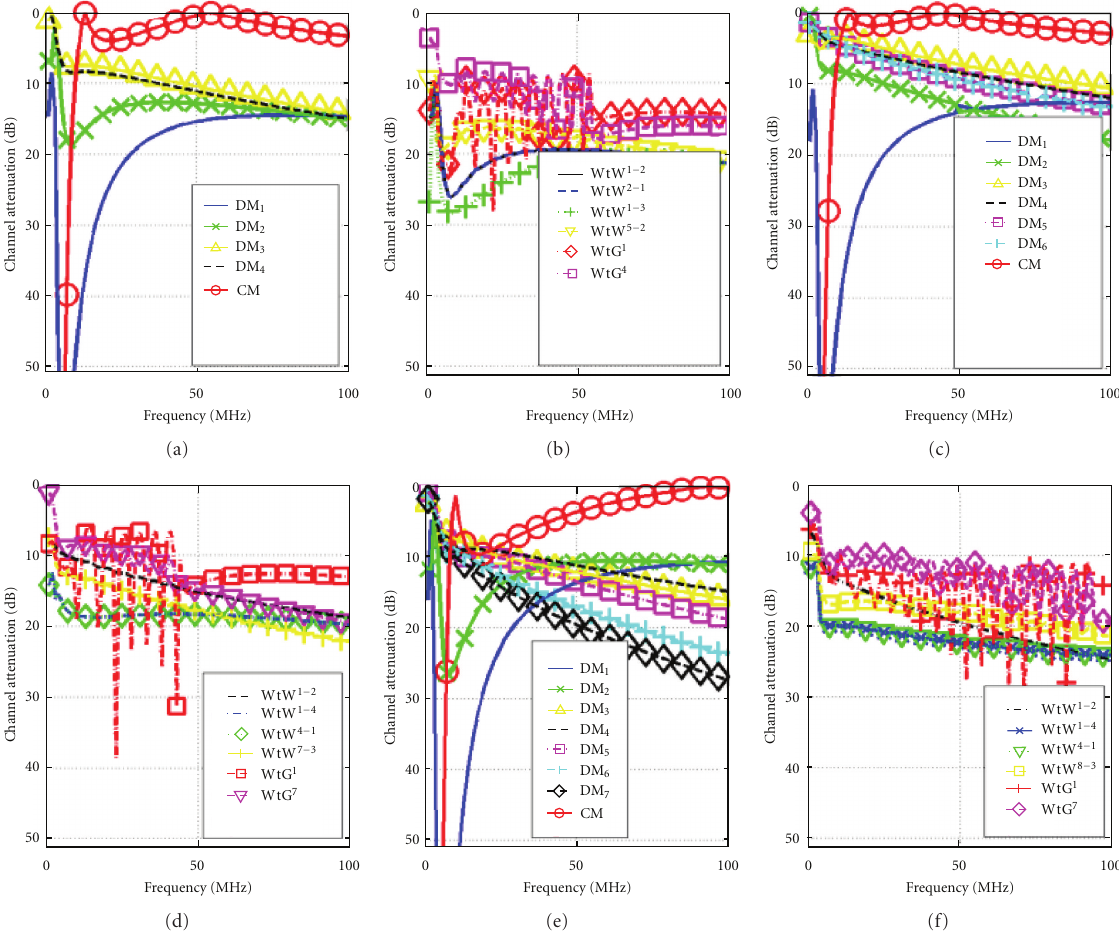
Figure 4: End-to-end channel attenuation versus frequency for “LOS” transmission case, (for plot clarity reasons, the subchannel frequency spacing is equal to 1MHz). (a, b) Modal and coupling scheme analysis of 150kV single-circuit, respectively. (c, d) Modal and coupling scheme analysis of 275 kV double-circuit, respectively. (e, f) Modal and coupling scheme analysis of 400 kV double-circuit, respectively.